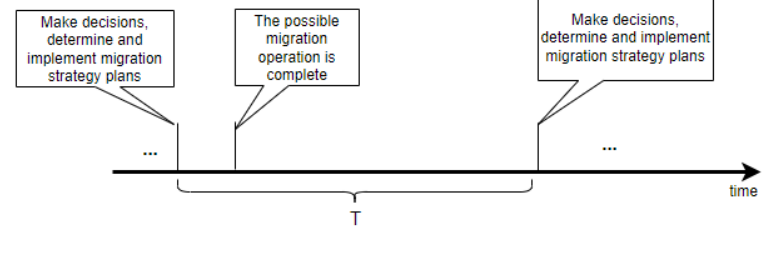
Figure 3. Time slot model.